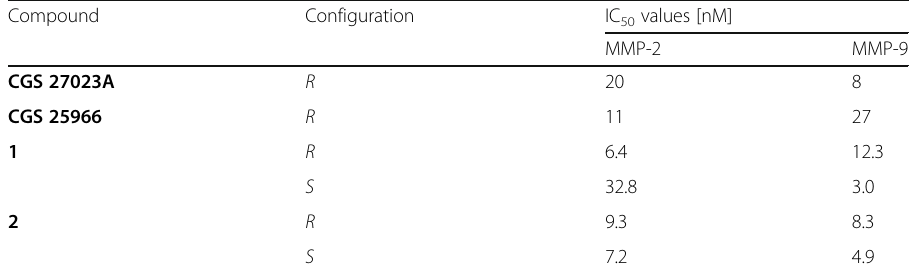
Table 1 IC 50 vcalues of CGS lead structures and γ -fluorinated MMP inhibitors 1 und 2 (Mac Pherson et al. 1997; Scozzafava et al. 2000; Behrends et al.